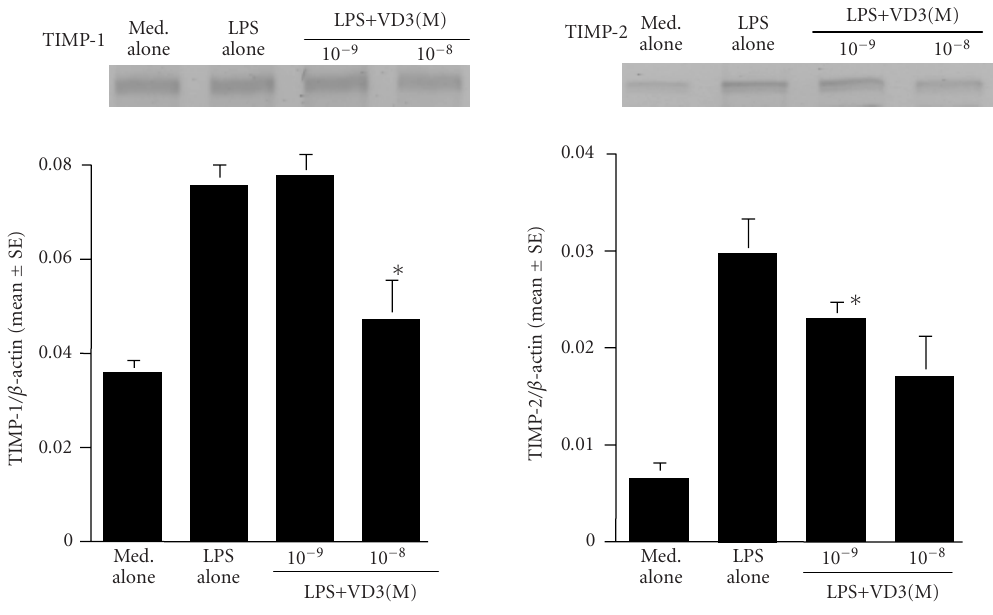
Figure 4. Influence of vitamin D3 on mRNA expression for TIMP-1 and TIMP-2 in keratinocytes after LPS stimulation. Details are shown in the legend of Figure 3.